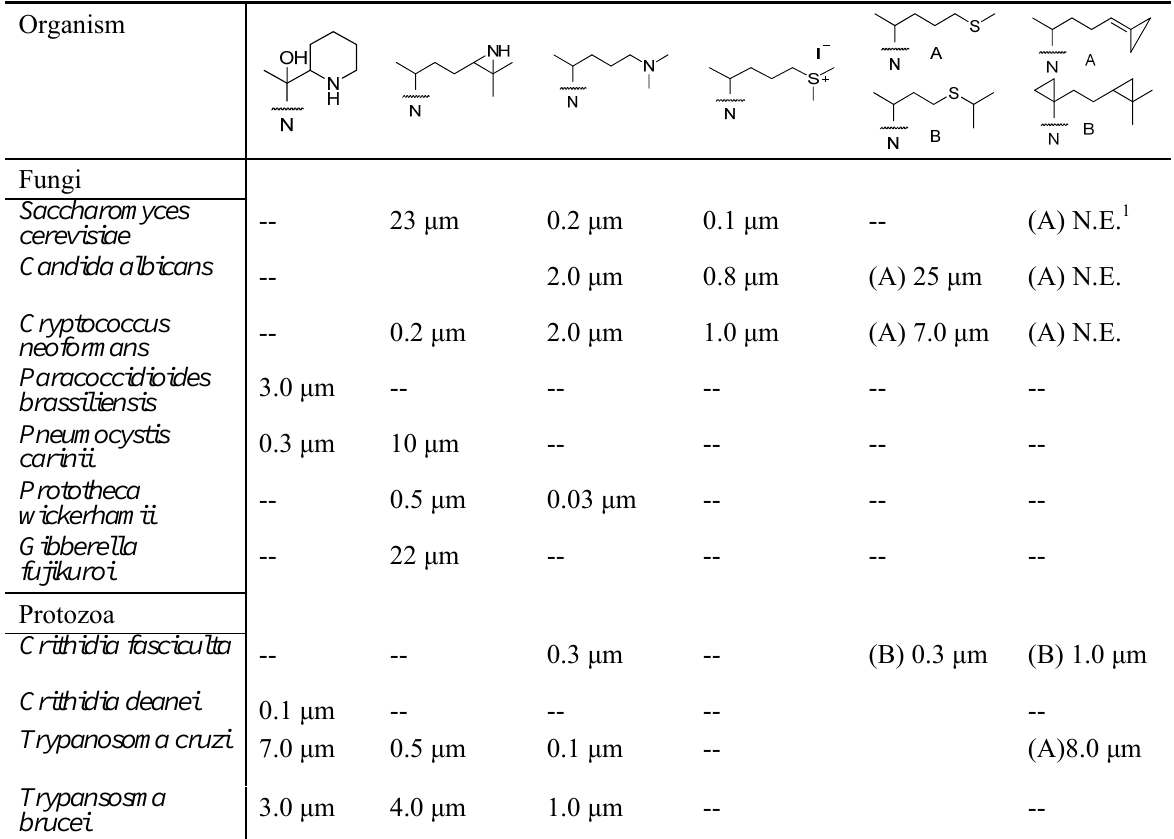
Table 1. Examples of the effect of sterol modifications on growth